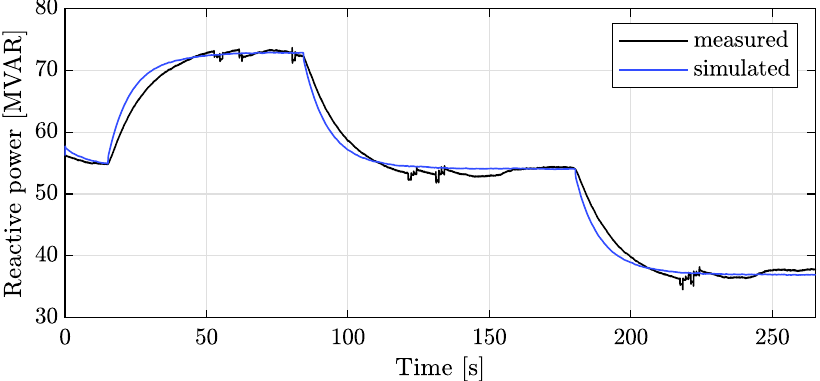
Figure 12. Volt/VAR Control Experiment 4 (over-excited power factor mode): reactive power reference step test. Comparison of simulations and experimental